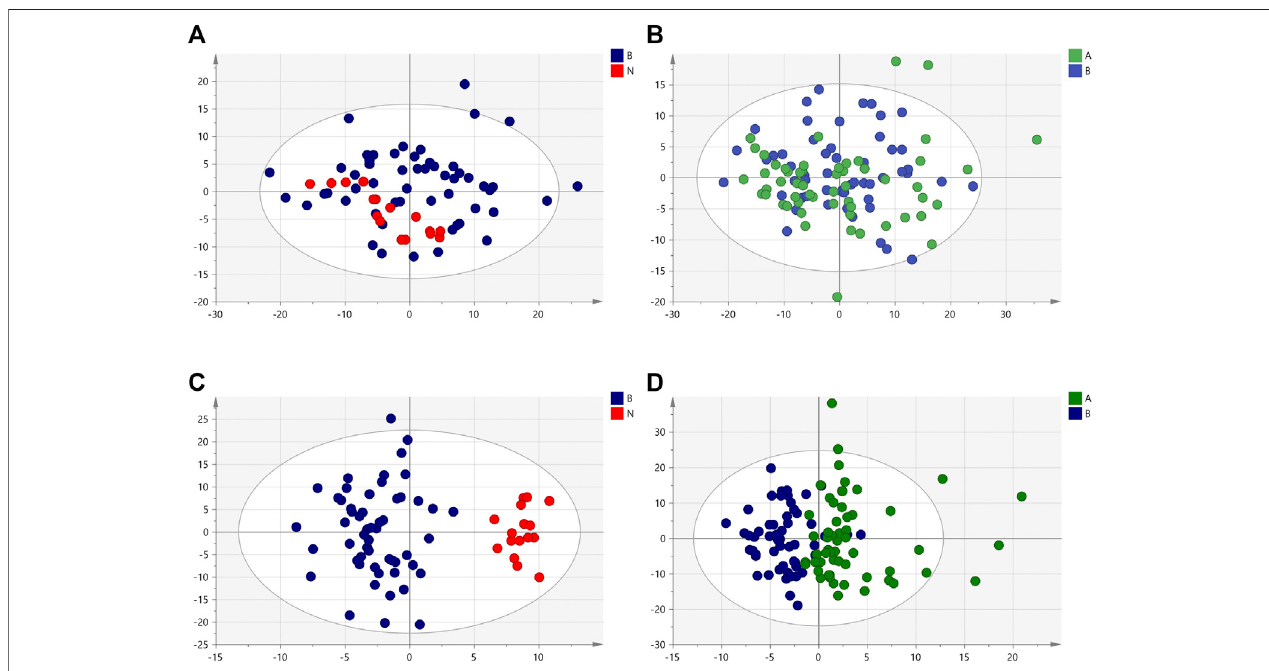
FIGURE 8 | The PCA and OPLS-DA score plots of lipid sample under positive ion mode. (A,C) Healthy control group and Oral disease group (B,D) Oral disease group and HLJDD intervention group. Red dot represents the healthy control group, blue dot represents the oral disease group, green dot represents the HLJDD intervention group.